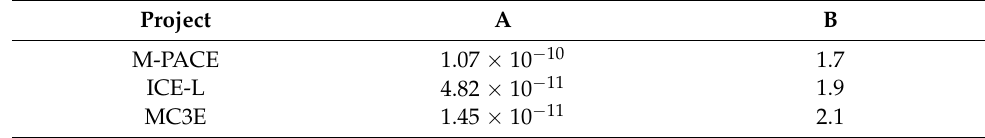
Table 2. The values of a and b in Equation (1) for different